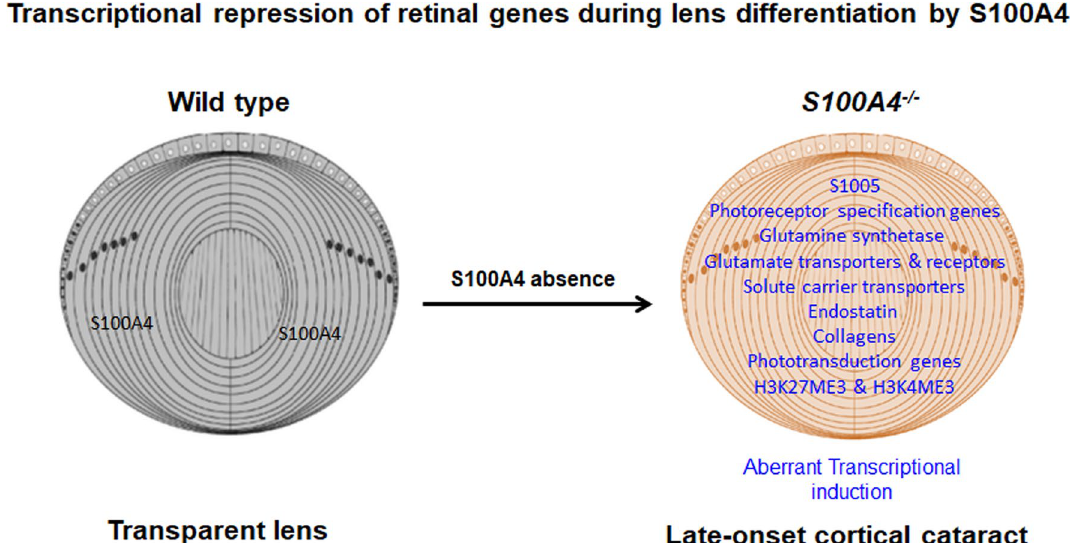
Figure 7. Graphical summarization of transcriptional repression of neurosensory genes during lens differentiation by S100A4. Absence of S100A4, a calcium binding protein expressed discretely in lens fibers within the mouse eye induces aberrant differentiation programs of non-lineage photoreceptor, Müller glia and olfactory sensory neurons in association with changes in histone-3 lysine (H3K) trimethylation markings, indicating a repressive role for S100A4 in suppressing expression of sensory neuron genes during lens differentiation. Lens drawings were adapted from the review article of Cvekl and Zhang (2017), and permission was obtained from Elsevier